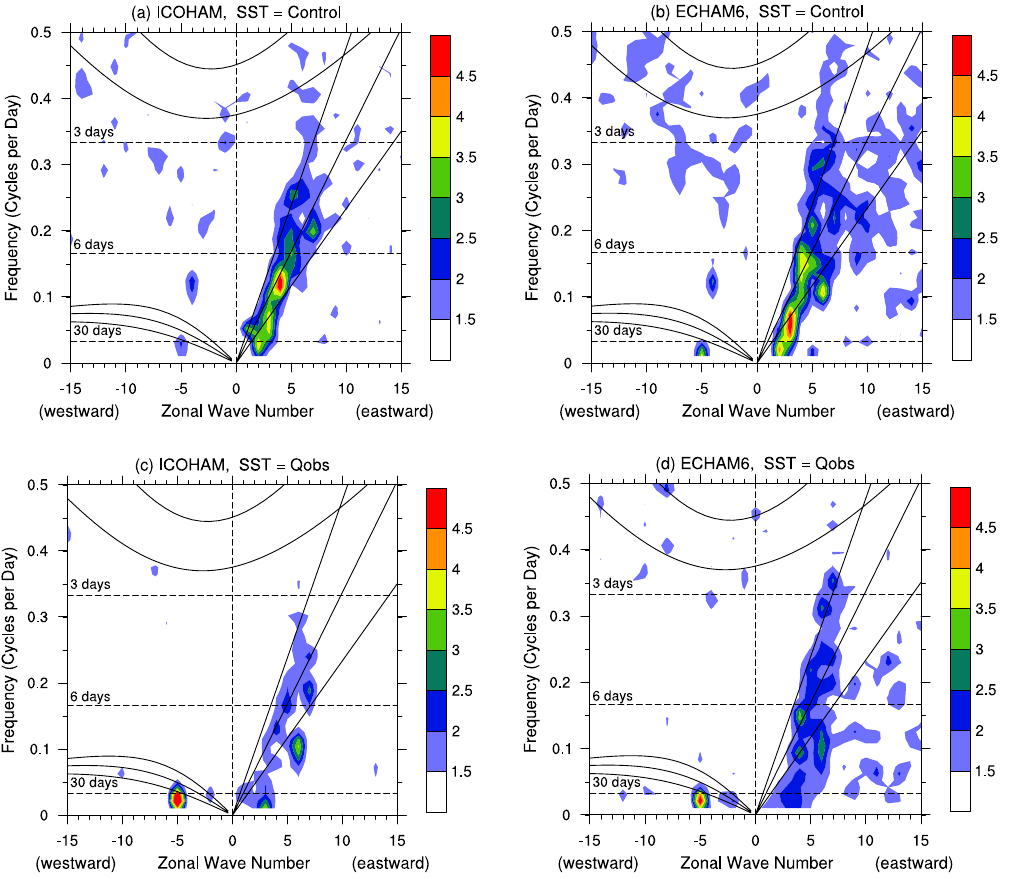
Fig. A1. As in Fig. 15 but showing the normalized spectra. Further details can be found in Sect.